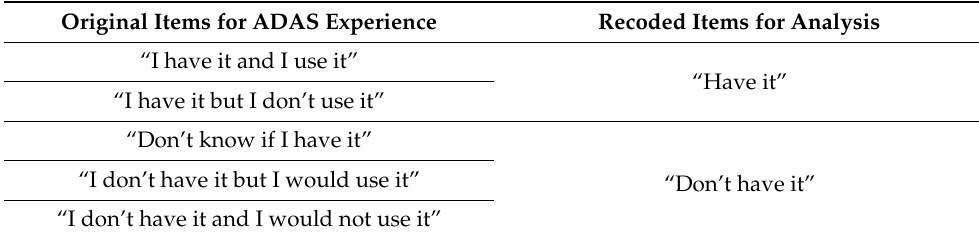
Table 2. Original and recoded items for ADAS